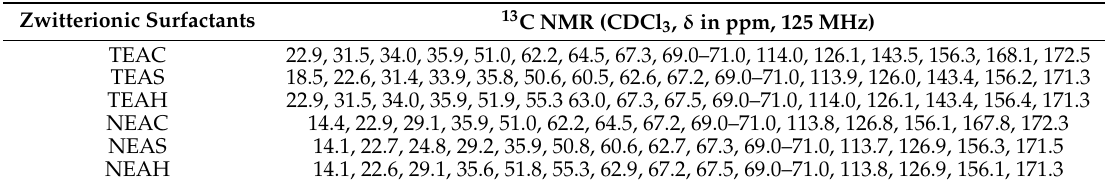
Figure 2. 1H NMR of TEAC. Table 2. 13 C NMR records displaying the values of chemical shift in zwitterionic